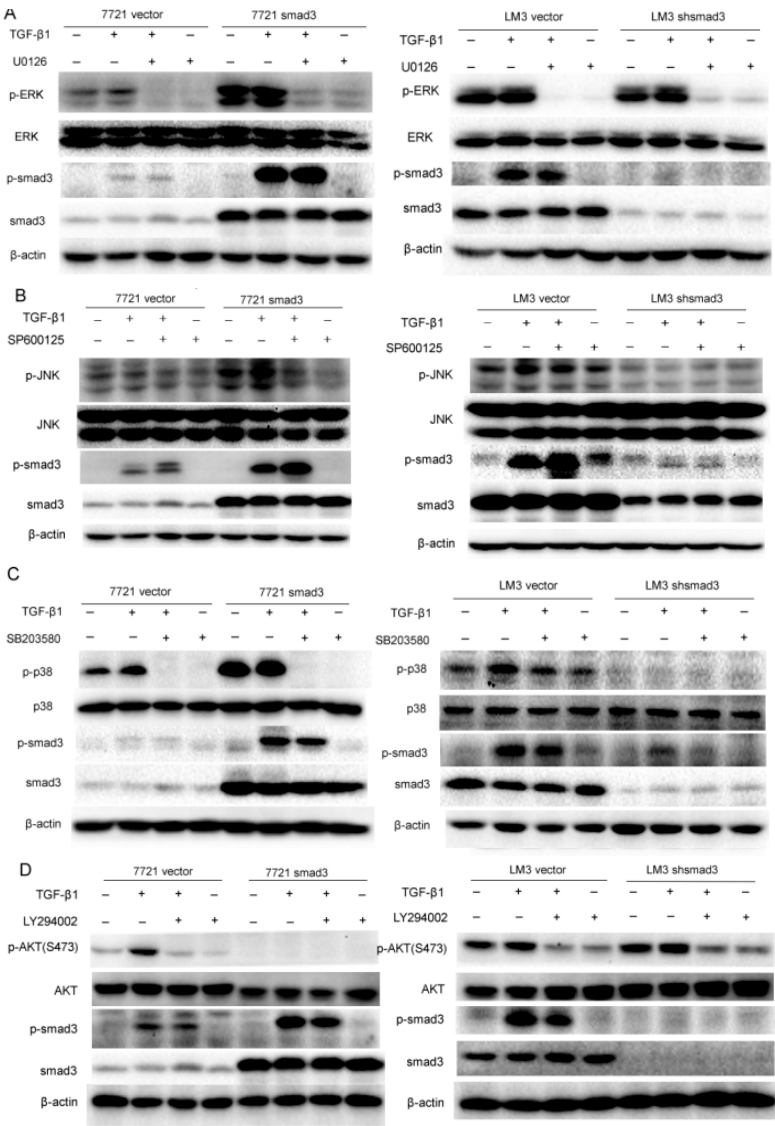
Figure 4. Smad3 activates mitogen-activated protein kinases (MAPK) but represses AKT signaling: ( A ) Extracelluar signal regulated kinase (ERK) and smad3 signaling were examined with the treatment of TGF- β 1 (5 ng/mL, 0.5 h) and U0126 (10 µM) in 7721 and LM3 cells; ( B ) JNK and smad3 signaling were examined with the treatment of TGF- β 1 (5 ng/mL, 6 h) and SP600125 (30 µM) in 7721 and LM3 cells; ( C ) P38 and smad3 signaling were examined with the treatment of TGF- β 1 (5 ng/mL, 1 h) and SB203580 (30 µM) in 7721 and LM3 cells; and ( D ) AKT and smad3 signaling were examined with the treatment of TGF- β 1 (5 ng/mL, 3 h) and LY294002 (20 µM) in 7721 and LM3 cells. All of the experiments were performed in triplicate and representative pictures are shown.